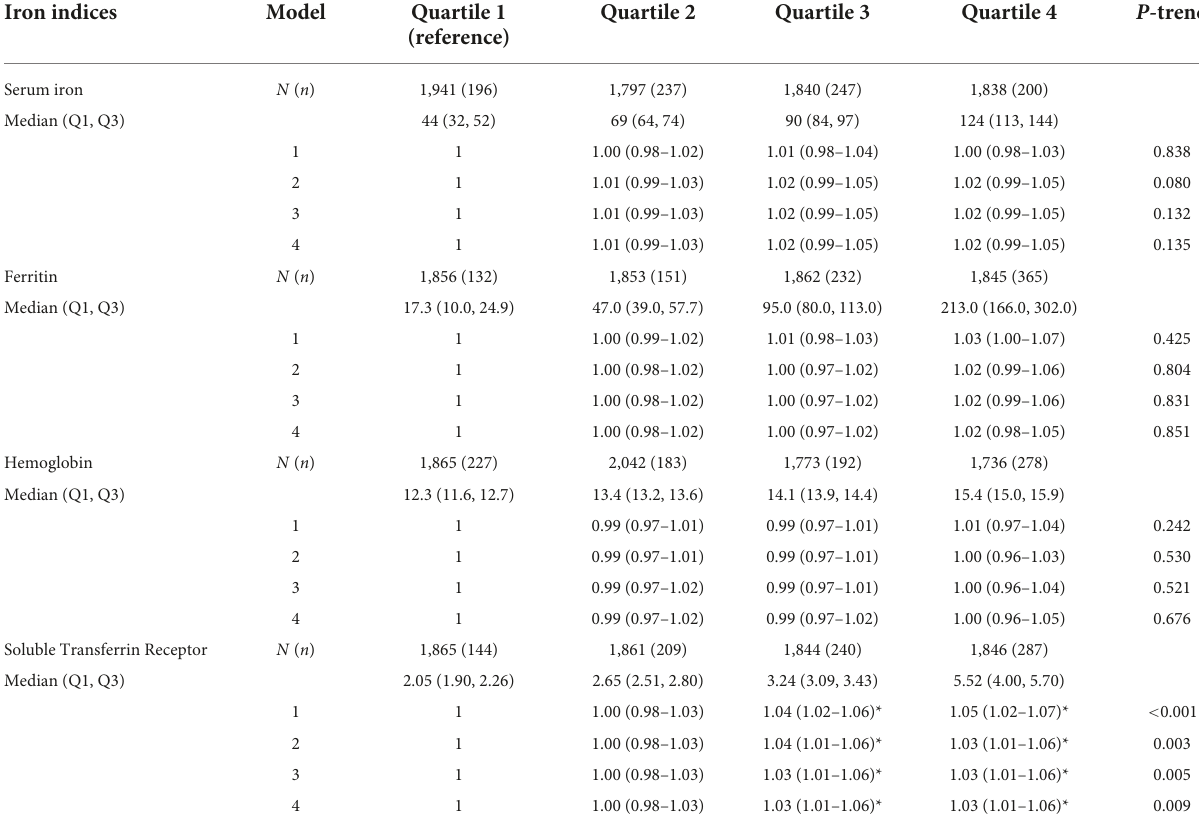
TABLE 3 Association between markers of iron metabolism (as quartile) and systolic hypertension in National Health and Nutrition Examination Survey (NHANES) 2007–2010 and NHANES